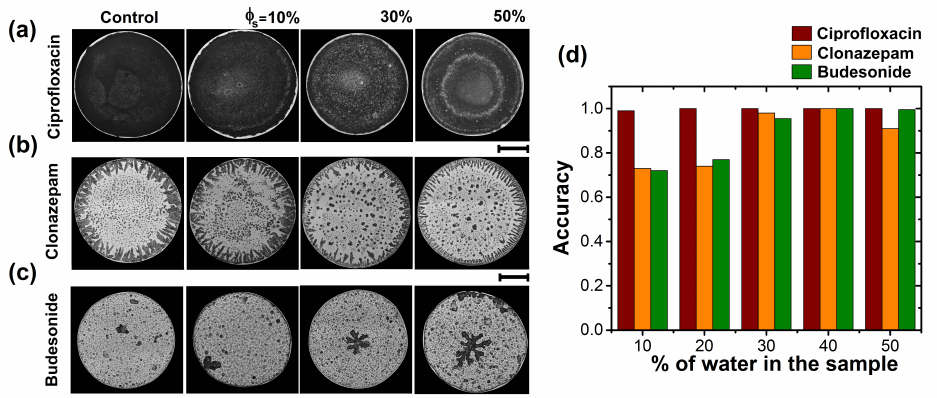
Figure 5. Recognition of Criprofloxacin, Clonazepam, and Budesonide. Patterns of dried droplets of ( a ) Criprofloxacin/NaCl, ( b ) Clonazepam/NaCl, and ( c ) Budesonide/NaCl produced by different dilutions of tap water. Patterns formation was carried out at T s = 63 ◦ C, and RH = 25%. The length of the black lines indicate 1 mm. ( d ) Accuracy for different medicines: Criprofloxacin/NaCl (red), Clonazepam/NaCl (orange), and Budesonide/NaCl (green). Texture analysis was carried out using different parameters: entropy of the entire deposit, entropy at the center of the deposit, and the superficial area of the aggregate formed in the center of the deposit,